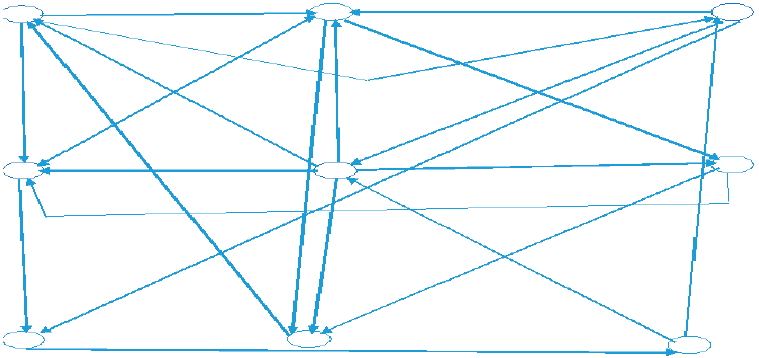
Figure 1. The representation of the network of nine NFIs. Source: Otilia Manta, based on her contribution.